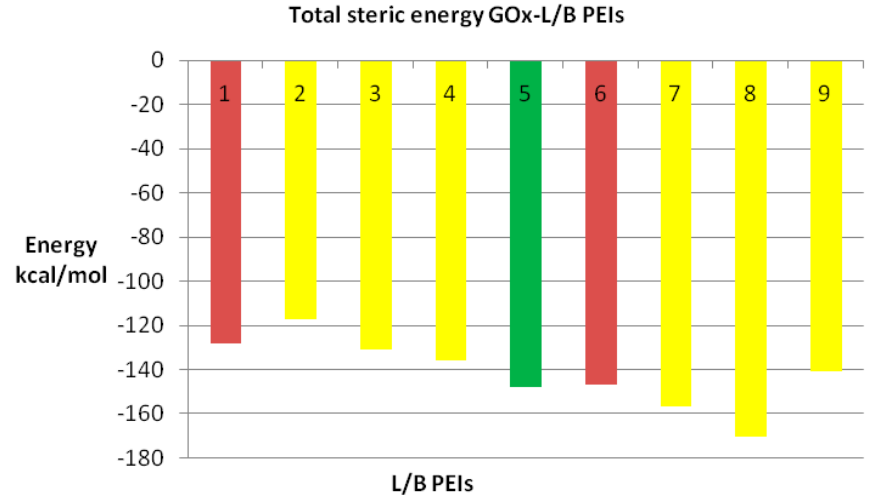
Figure 12. Steric energy of GOx-L/B PEIs complex (from left to right): 1 and 6 L PEI C14 and C18 (in red); 2 to 4 and 7 to 9 represent the corresponding branched isomers B PEIs (in yellow); LPEI C16 isomer is represented in green (see also Figure 11).